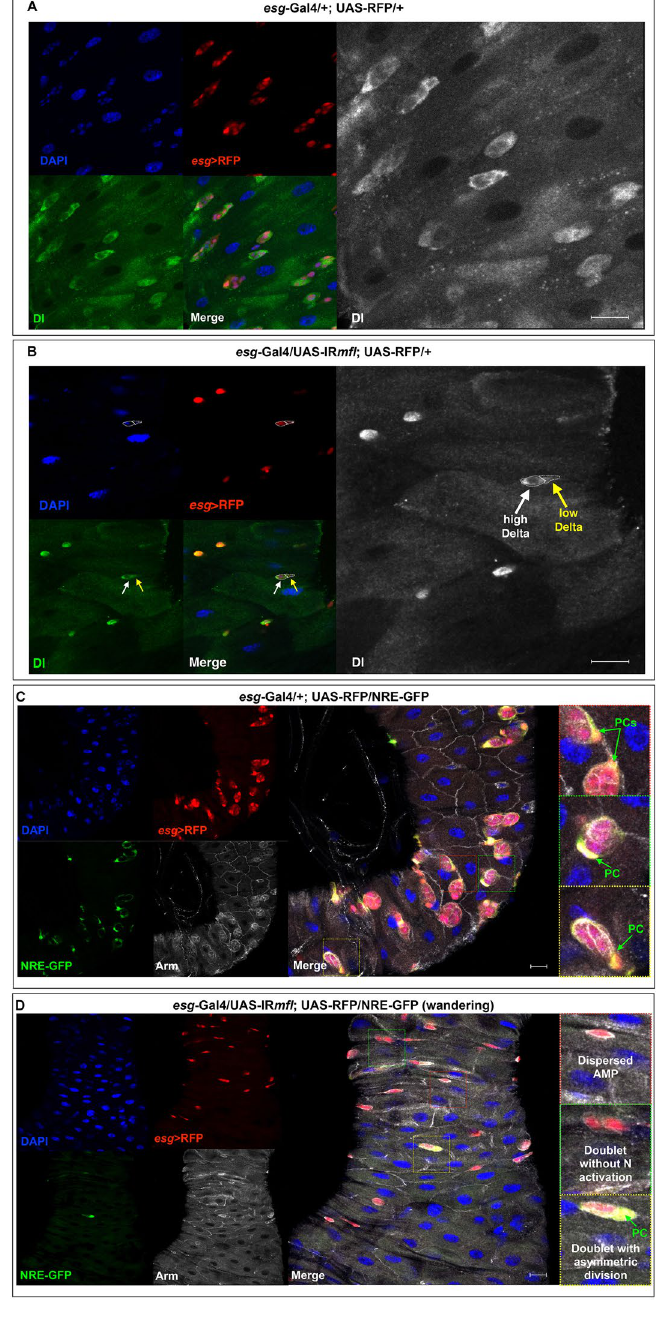
Figure 7. Dyskerin-depleted midgut stem cell precursors can preserve stemness markers. Confocal images of third instar larval midguts were immunostained with anti-Dl (in green; in grey in the enlargements) and anti-Arm (in grey); DAPI is in blue; the esg expression domain is marked in red by RFP, and Notch activation is marked in green by the NRE-GFP reporter. Scale bars: 20 µ m. In control midguts, Dl localizes in membrane of esg + cells clustered into imaginal islands ( A ); in silenced midguts ( B ), it localizes in membrane of esg + singlets. In addition, Dl is highly expressed in only one member of some doublets (see white arrow), while the other cell shows very poor immunoreactivitiy (yellow arrow). In control midguts ( C ), Arm abundantly accumulates in the adherence junctions of the esg + cells forming the imaginal islands, while Notch activation specifically marks the peripheral cells (PCs) surrounding each island. In silenced midguts ( D ), Arm surrounds esg + MFL-depleted singlets and abundantly accumulates at the adherence junctions of the doublets; in keeping with Dl expression, Notch is found asymmetrically activated in some